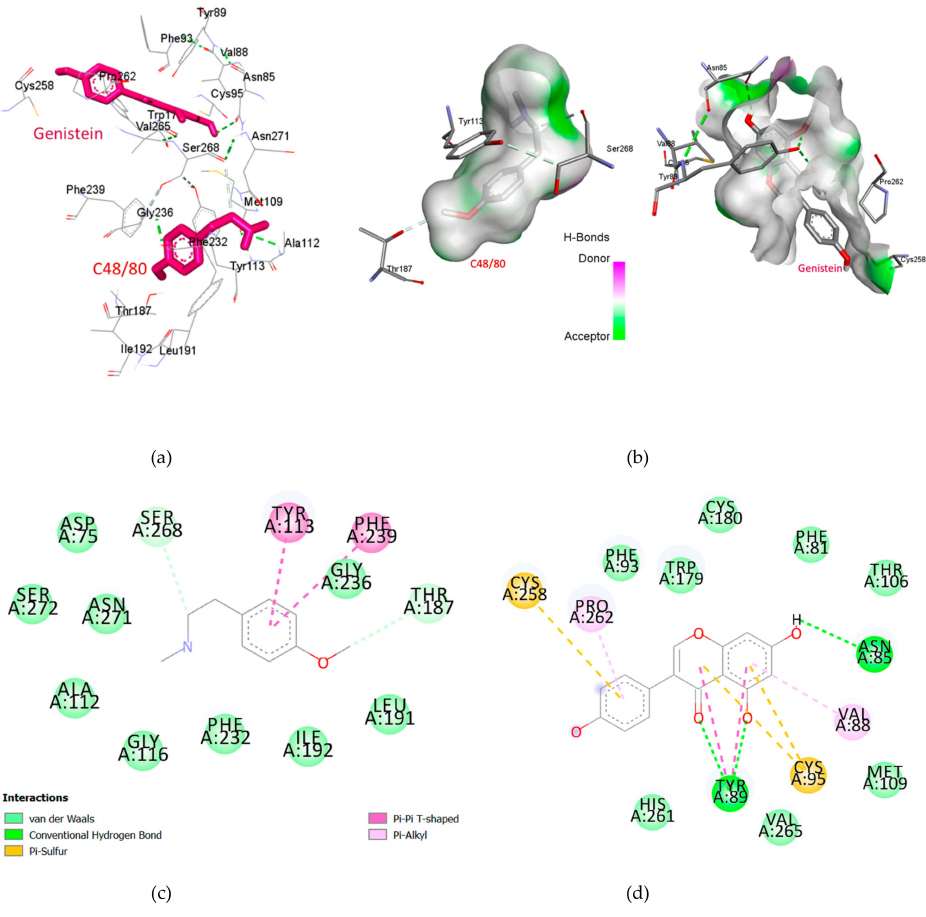
Figure 3. A three-dimensional representation of binding orientation ( a ) and hydrogen bond formation ( b ) of Compound 48 / 80 and Genistein with MRGPRX2. Two-dimensional representation of interactive amino acid and interaction bond of MRGPRX2 with compound 48 / 80 ( c ) and Genistein ( d ). 2.4. In-Vivo Inhibitory E ff ect of Genistein against Local Anaphylaxis Mice